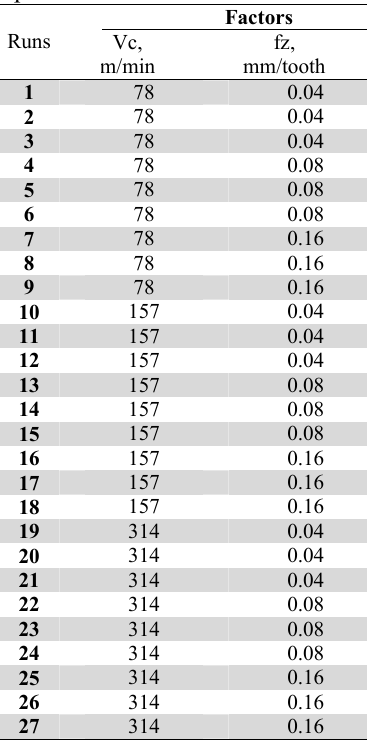
Experimental data for AISI 1040